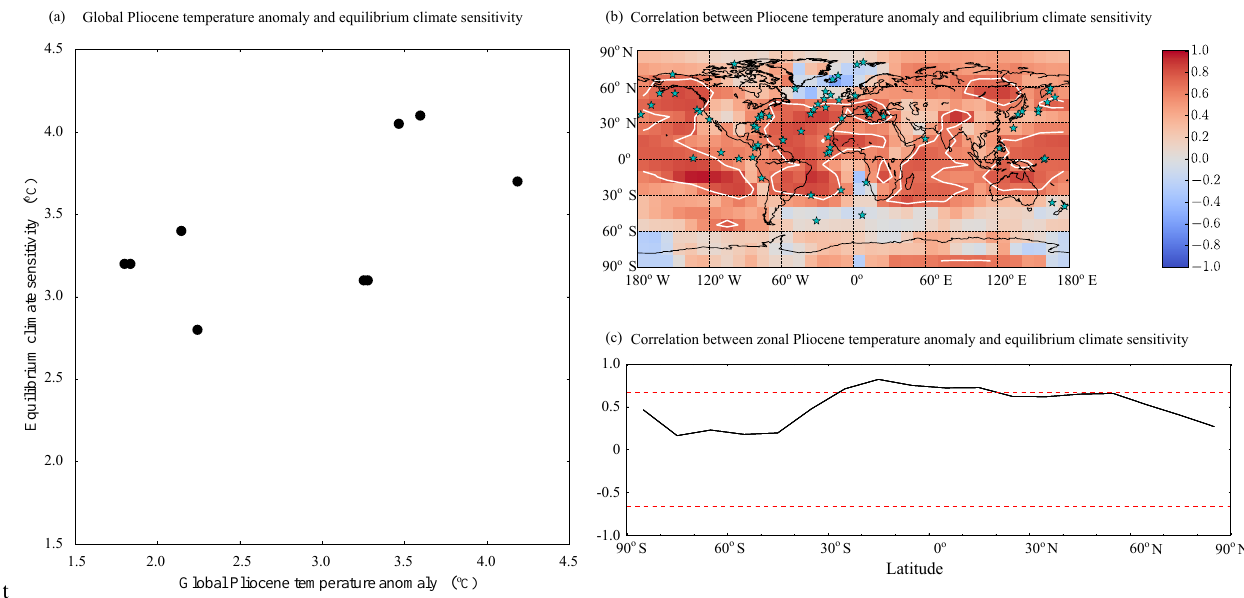
Figure 1. Correlations between the PlioMIP anomalies and climate sensitivity. For the Pliocene, the annual SAT anomalies were obtained from averaging the monthly climatology files on the PlioMIP database. For CCSM a 500-year time series is available, so the average over the last 100 years was used. (a) Globally averaged PlioMIP anomaly vs. the estimated equilibrium climate sensitivity from Table 1. (b) The Pliocene temperature anomalies were averaged onto a 10 ◦ grid and correlated with the global equilibrium sensitivity in each grid box. Cyan stars indicate locations of data points. (c) Zonally averaged results. The dashed lines in plot (c) indicate the 95% significance threshold for a two-sided t